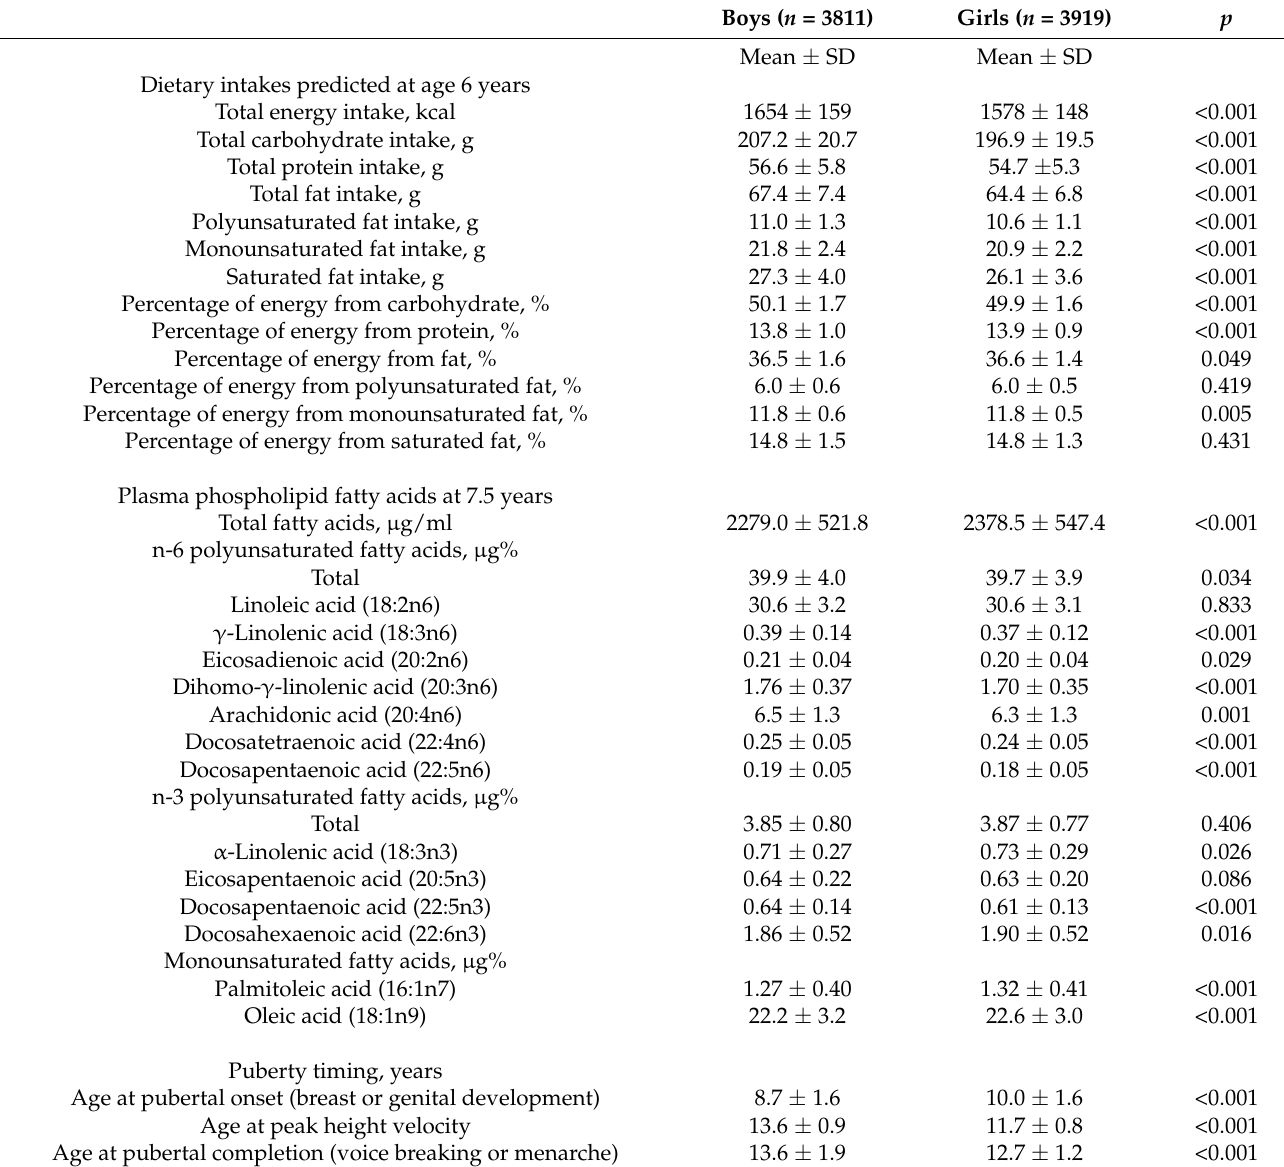
Table 1. Macronutrient intakes, plasma phospholipid fatty acids, and puberty timing in boys and girls in the ALSPAC study.